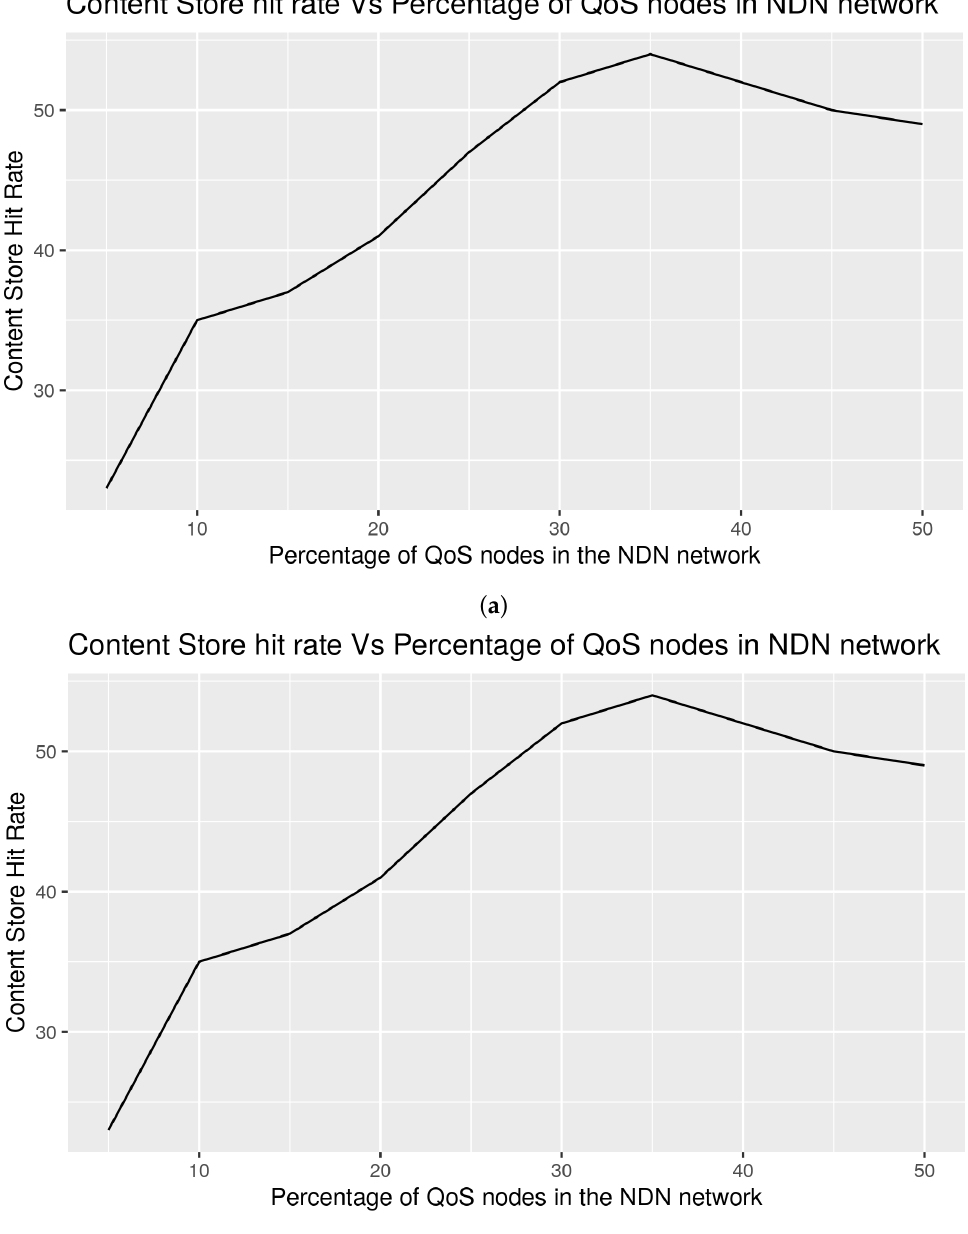
Figure 4. Content store hit rate vs. percentage of QoS nodes in the network. ( a ) Content store hit rate vs. percentage of QoS nodes in the network for | M | = 500 . ( b ) Content store hit rate vs. percentage of QoS nodes in the network for | M | = 1000